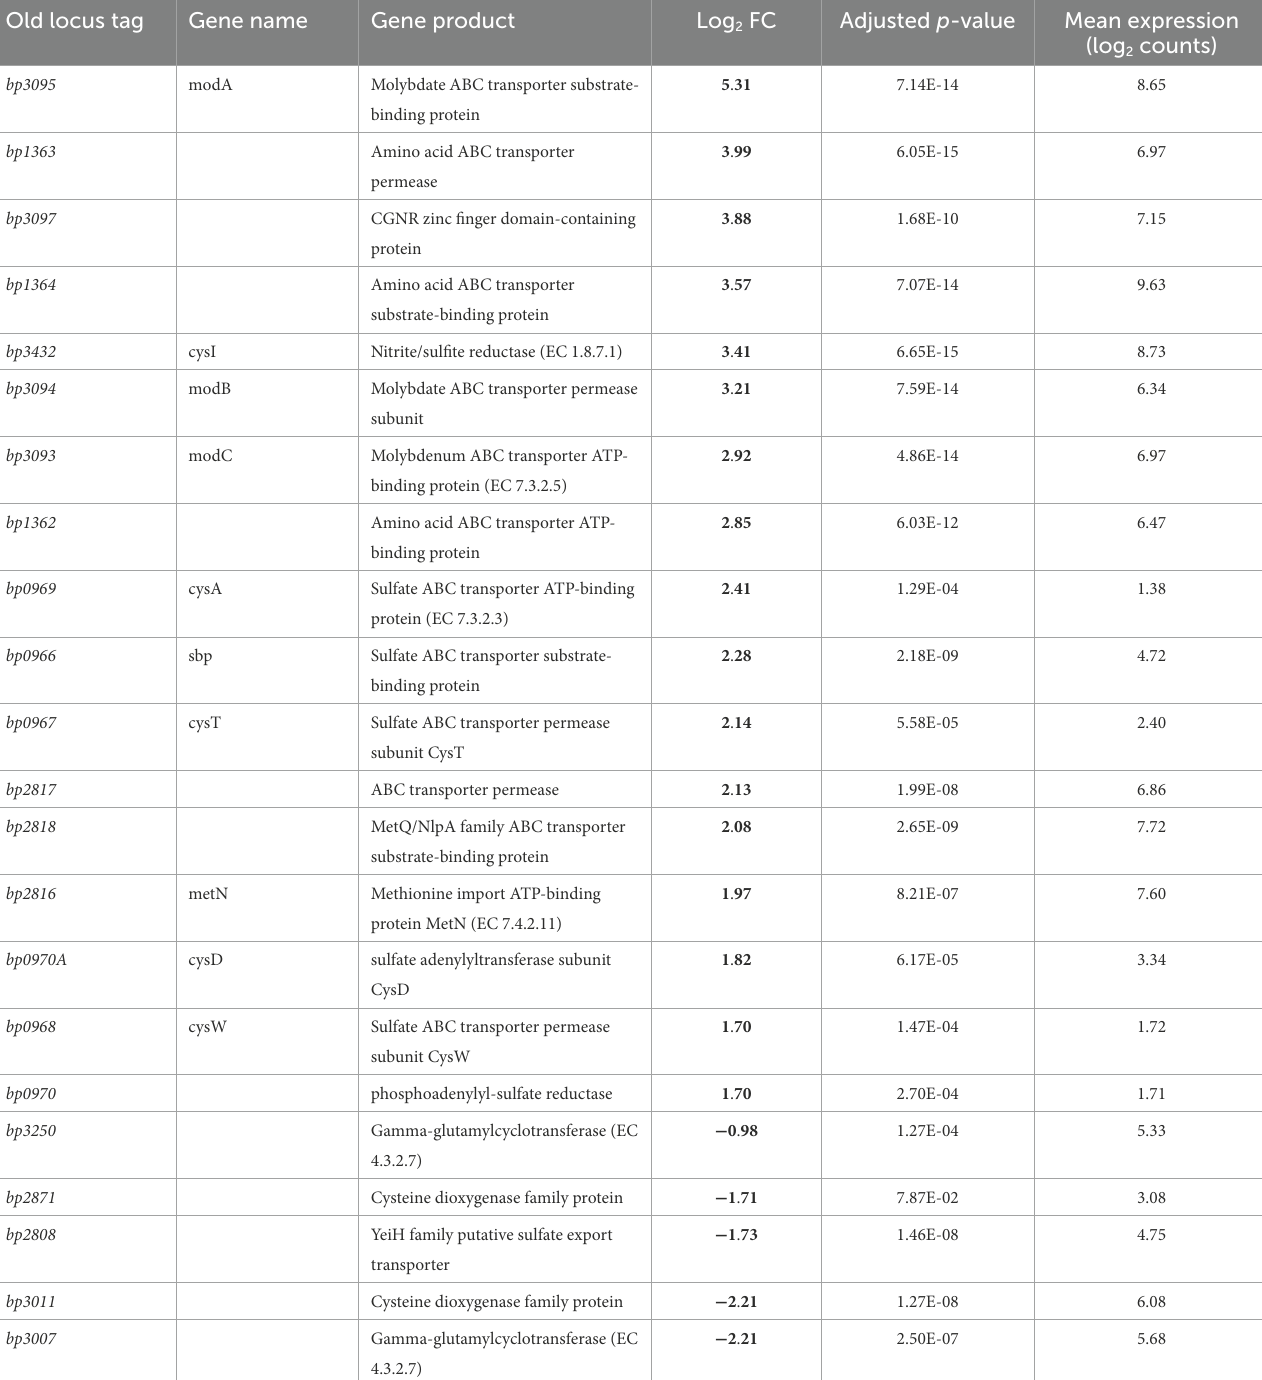
TABLE 1 Main differentially expressed genes involved in sulfur metabolism between 4 and 8 h of culture. Old locus